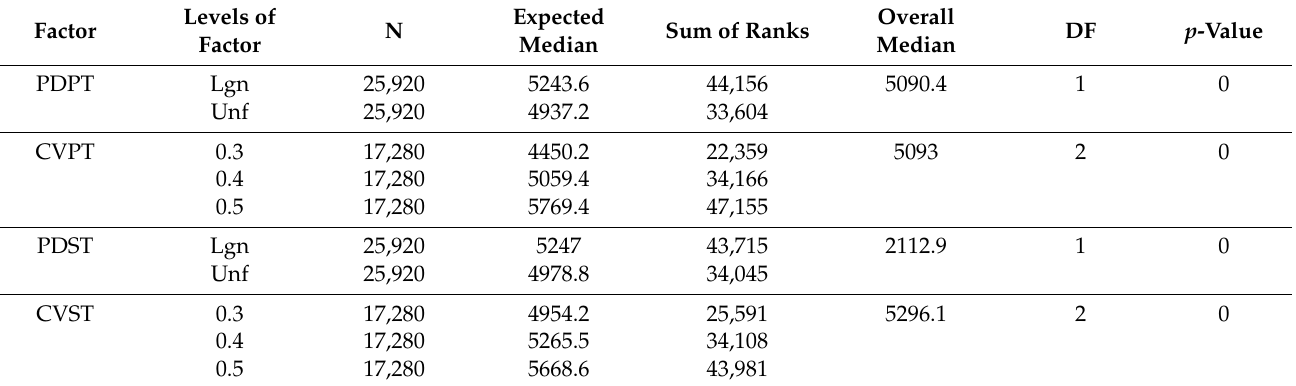
Table 10. Friedman test for SD(E/T) versus the factors PDPT, PDST, CVPT, and